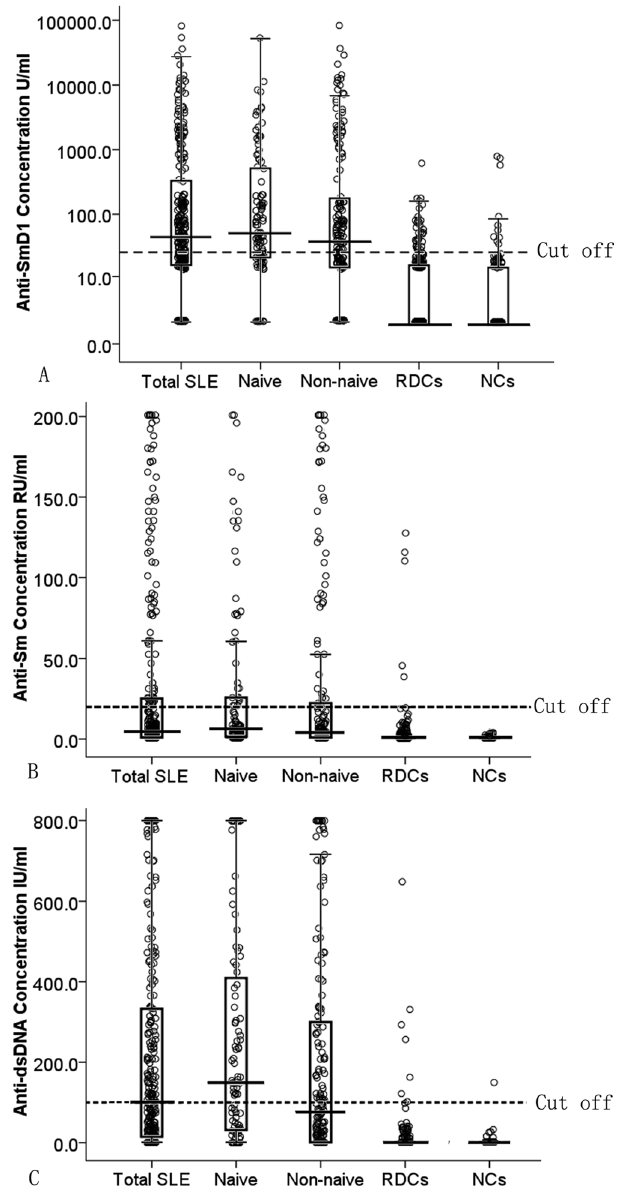
Figure 1. Quantification of serum anti-SmD1, anti-Sm, and anti-dsDNA antibody concentrations in SLE patients, rheumatic disease control and healthy